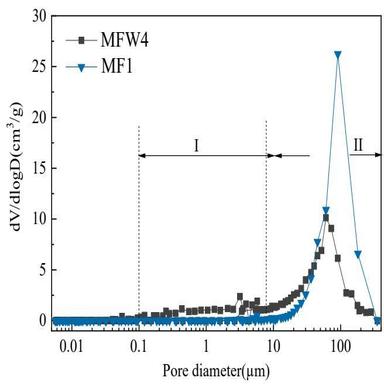
The curves of pore size distributions of the MFW4 and MF1.